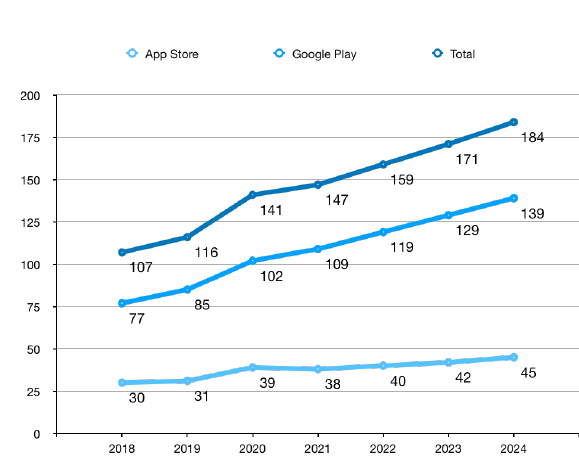
Figure 3. Mobile app downloads worldwide from